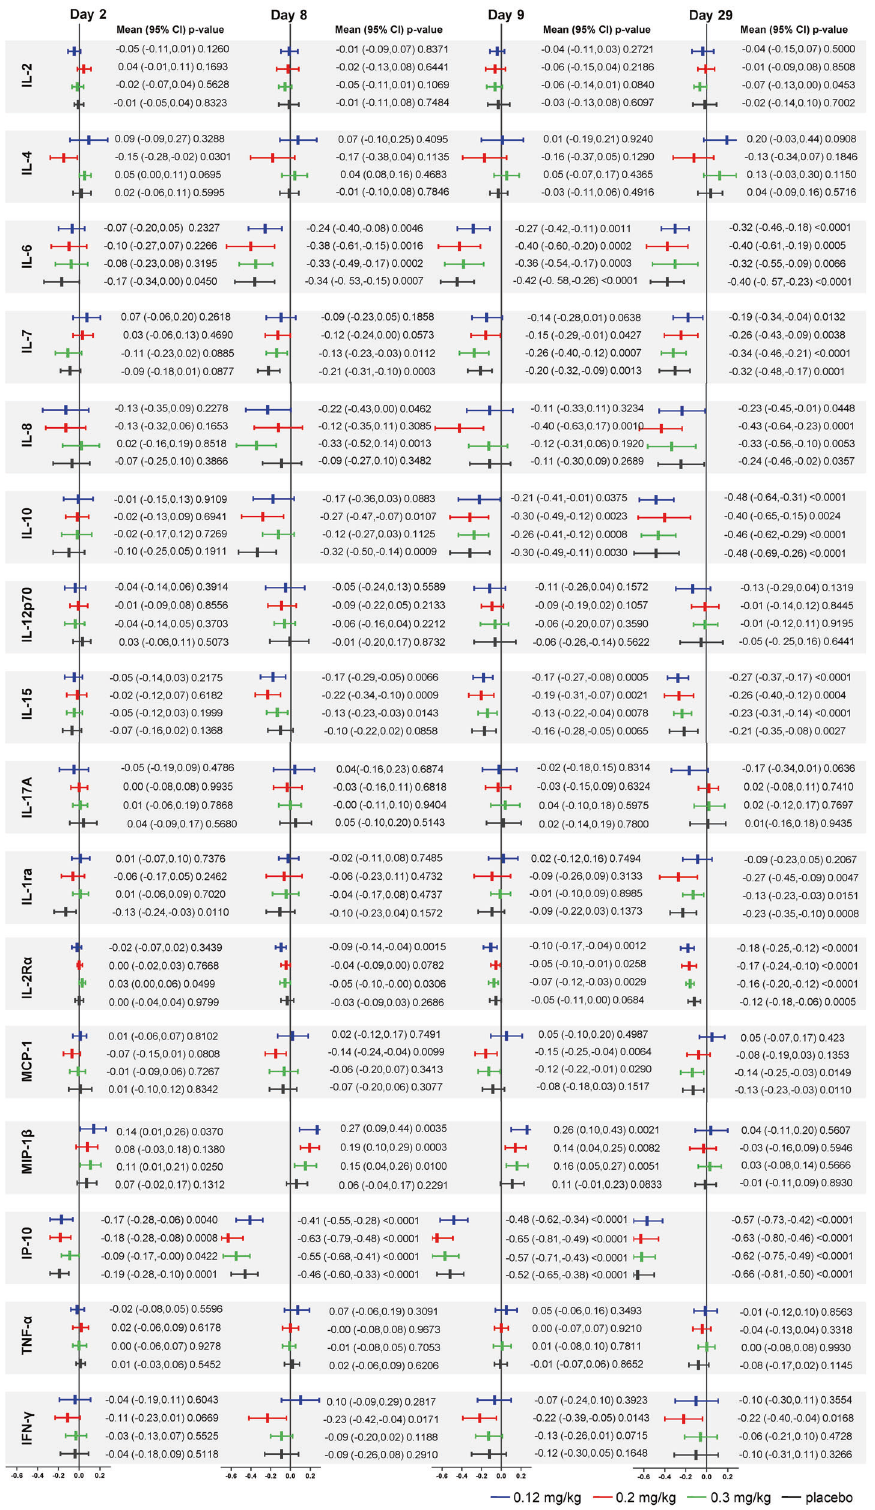
Fig. 3 Forest plot of cytokine level changes from baseline (log10). The levels of cytokine/chemokines were converted to logarithmic form before statistical analysis and presented in the form of mean (95% CI). The paired t-test was used to compare the cytokine level at each time point with baseline in each group